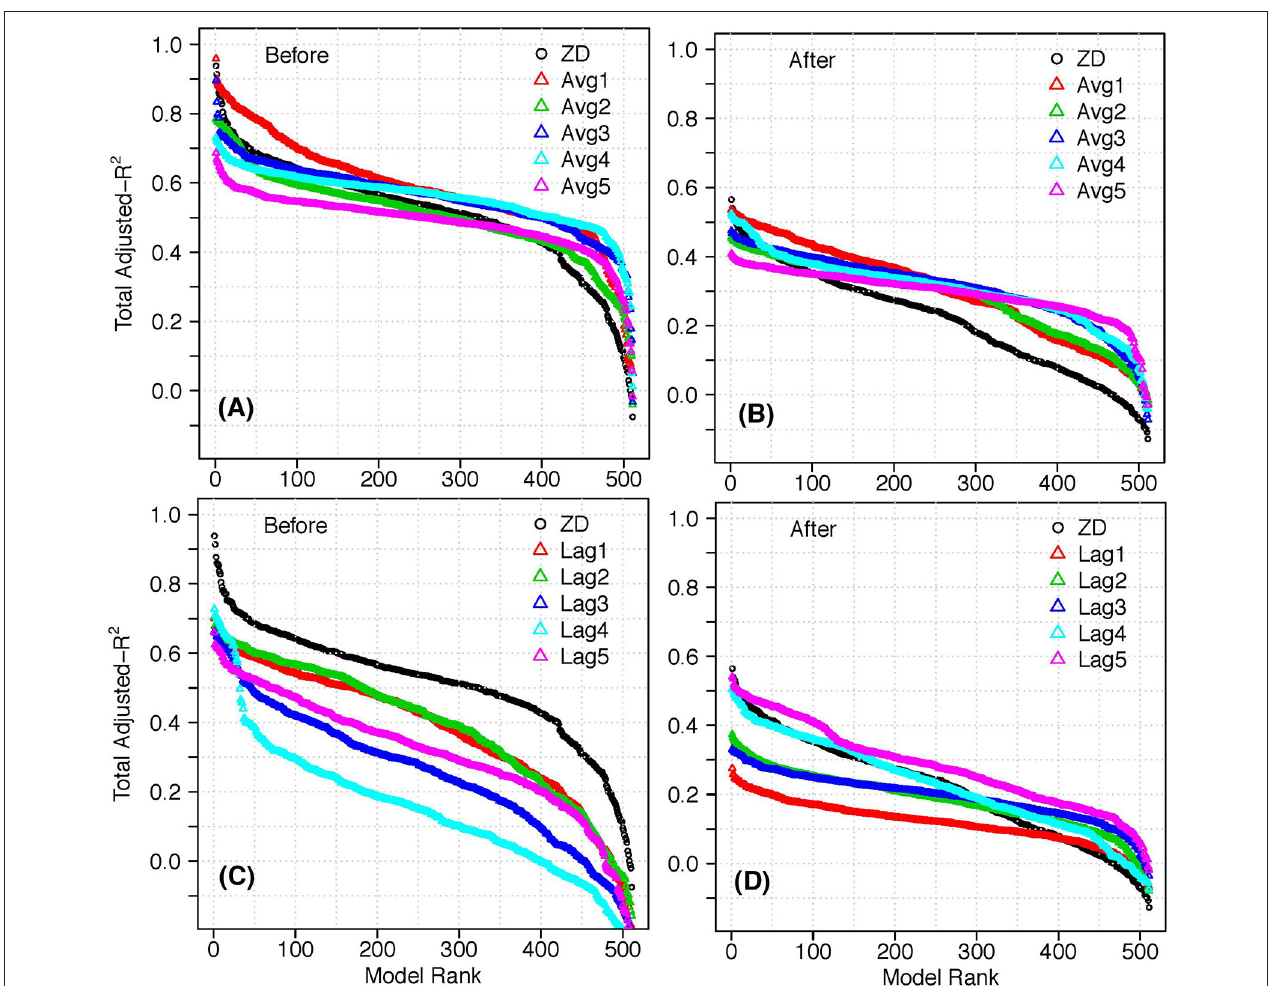
FIGURE 7 | Adjusted-R 2 Total in decreasing rank for models using predictors with time delays: (A) Before models, moving average predictors; (B) After models, moving average predictors; (C) Before models, lag predictors; (D) After models, lag